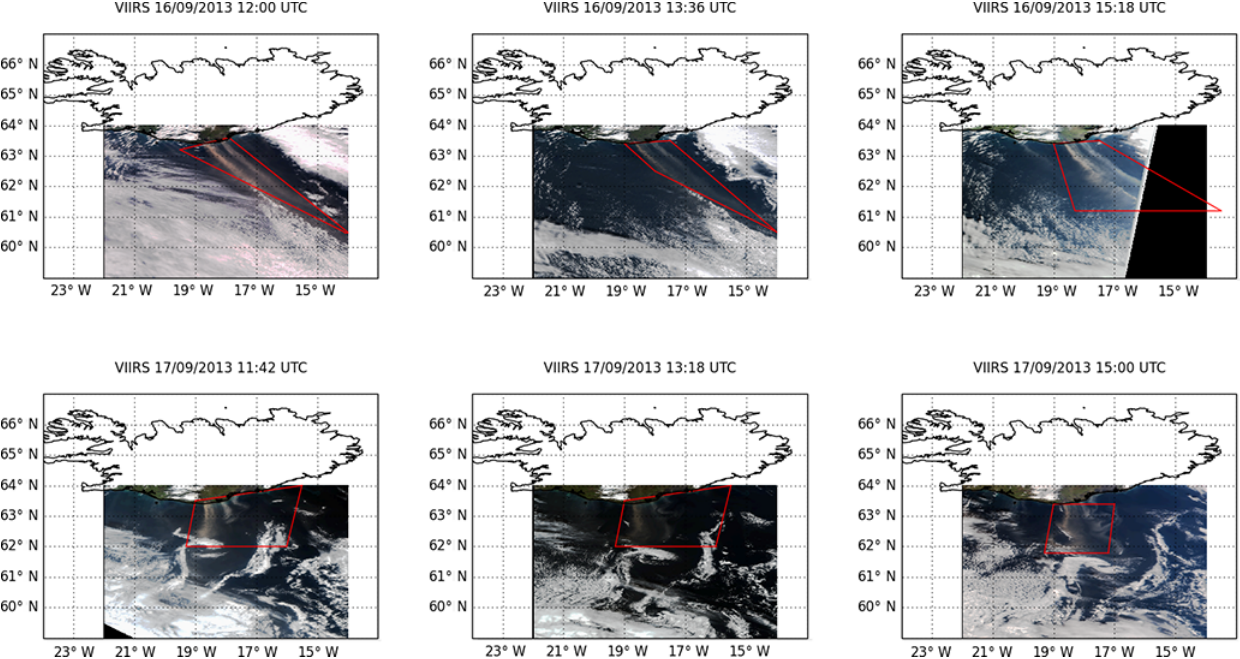
Figure 4. VIIRS daytime RGB composites using bands M3, M4, and M5 for 16–17 September 2013. Areas identified as containing resus- pended ash (see Sect. 3.3) are enclosed within the red